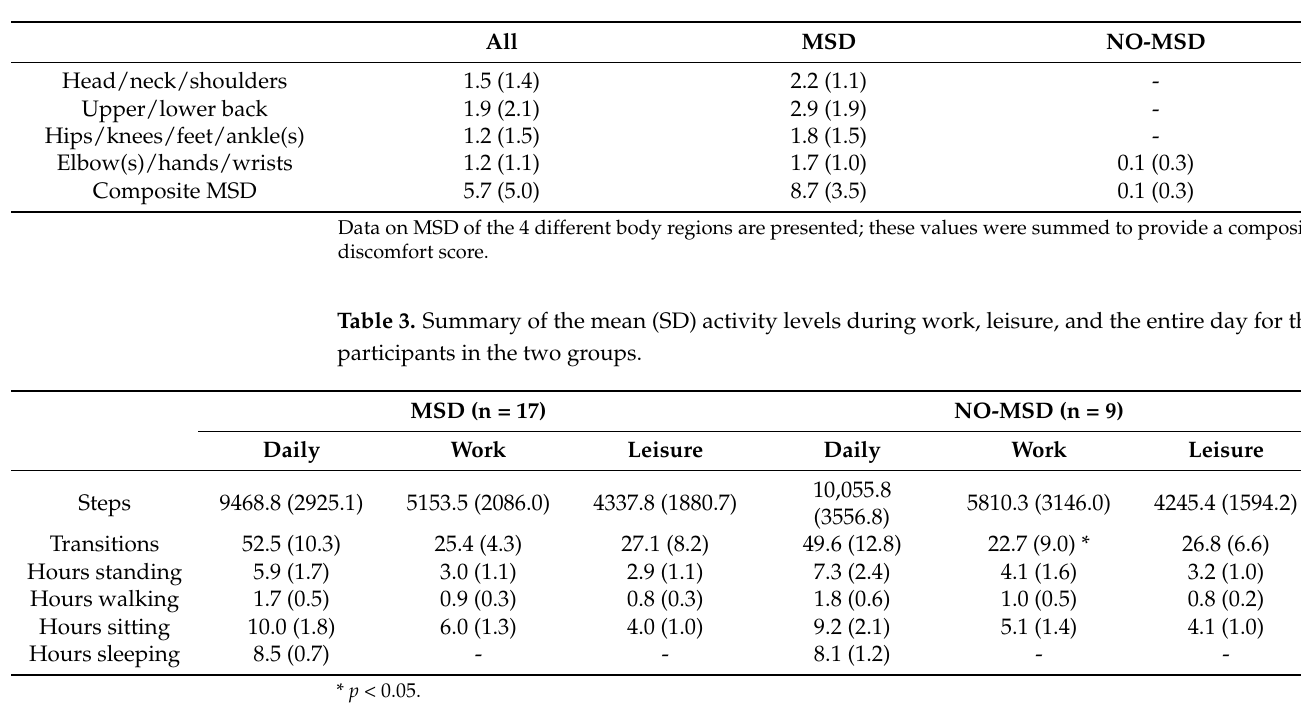
Table 2. Summary of musculoskeletal discomfort levels collected at baseline. Values are expressed as mean (standard deviation).